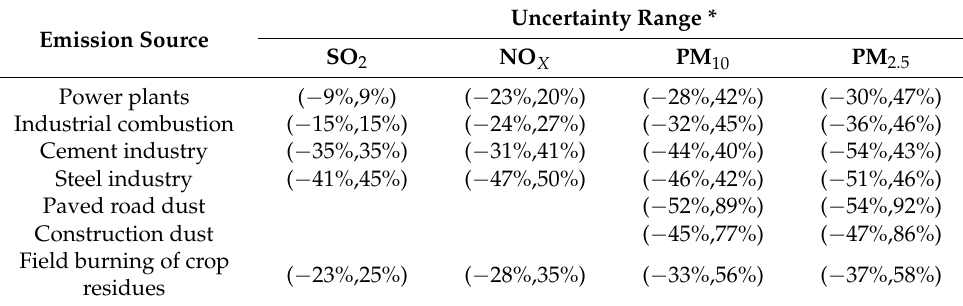
Table 4. Uncertainty assessment of major emission sources estimated in